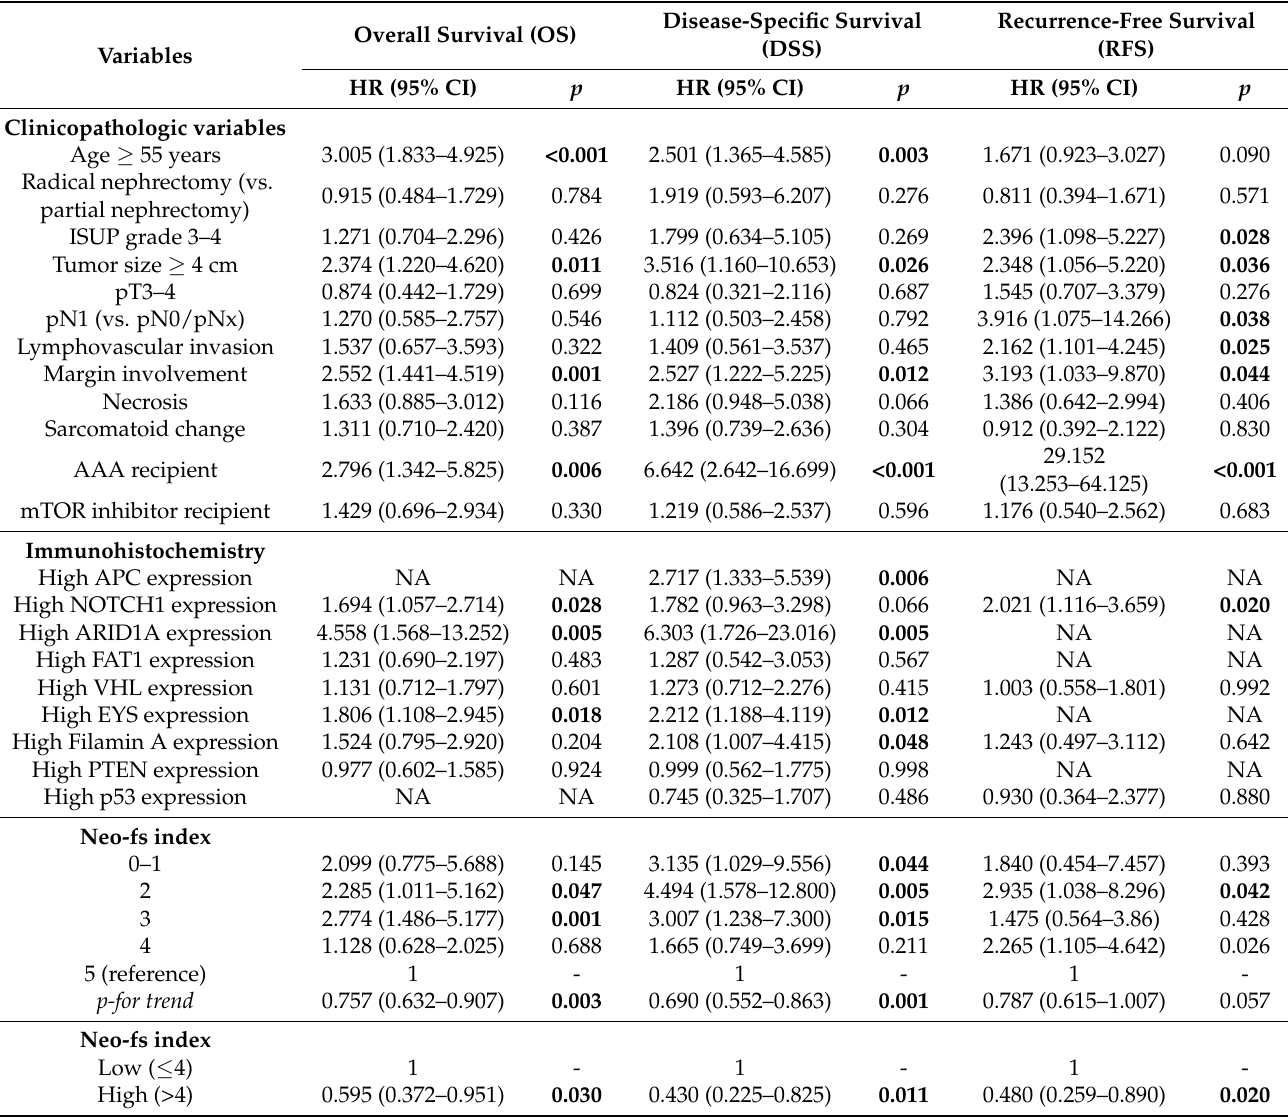
Table 3. Multivariate analysis to identify a correlation between survival and clinicopathological factors and immunohisto- chemical results in patients receiving anti-angiogenic